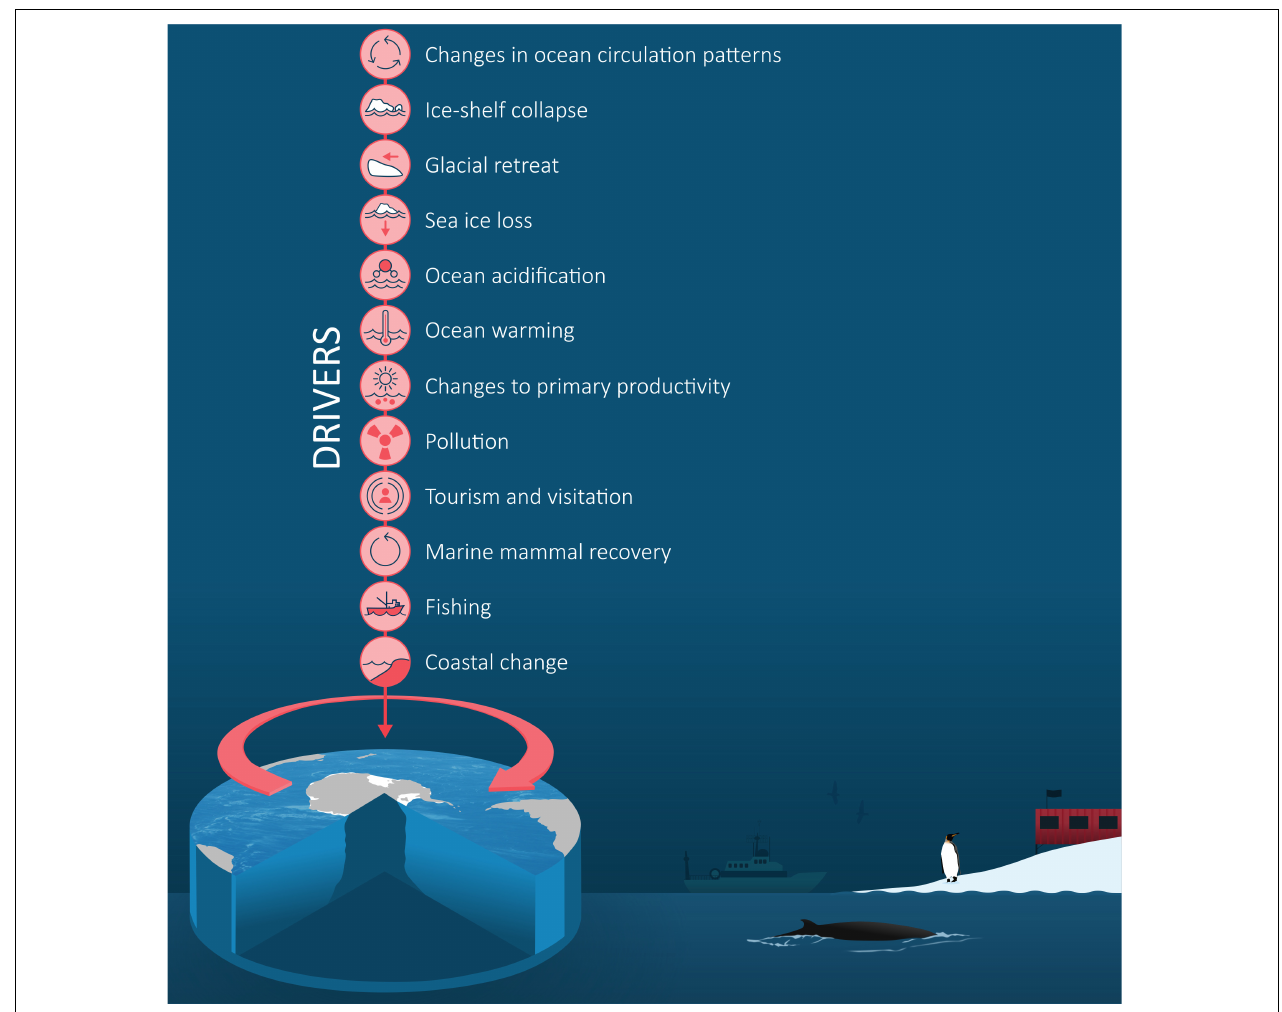
FIGURE 2 | Key drivers of change in metazoan zooplankton taxa within the Southern Ocean. For a complete description of global and local drivers of change in Southern Ocean ecosystems see Morley et al. (2020) and Grant et al.